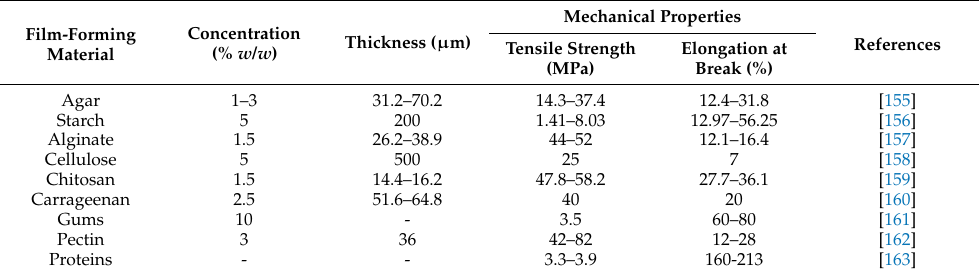
Table 6. Typical values of tensile strength and percent elongation at break of commonly used edible coatings and films, as a function of the film-forming material, its concentration, and resulting thickness.